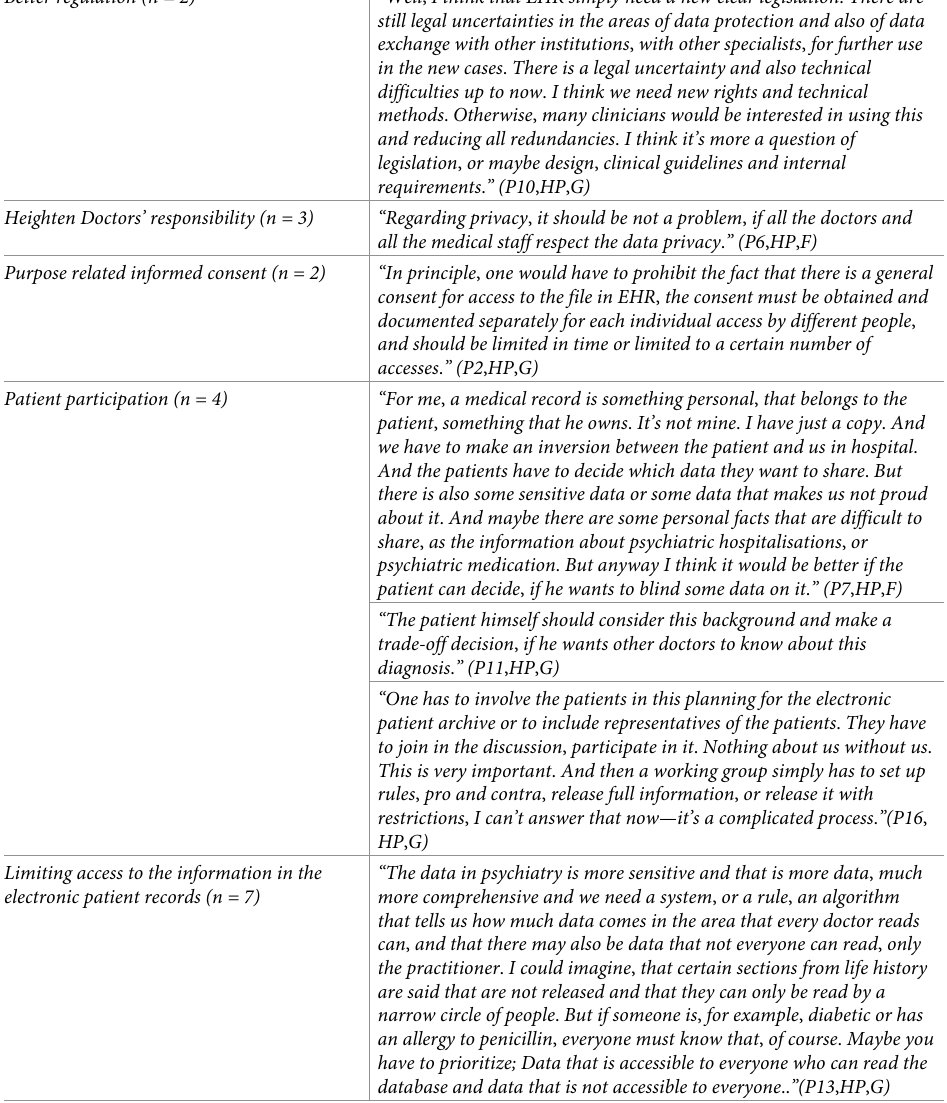
Table 4. Possible ways to preserve data